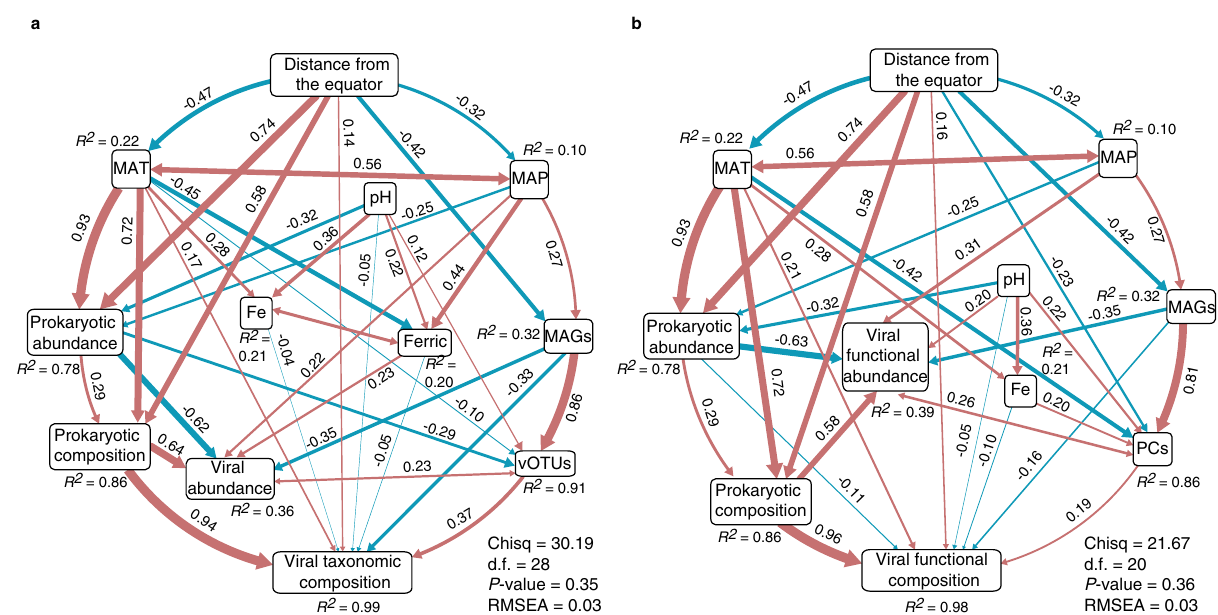
Fig. 3 Drivers of viral taxonomic and functional diversity and compositions. Path diagram for SEM showing only signi fi cant direct and indirect effects of biotic and abiotic variables on viral taxonomic a and functional b diversity and compositions. Composition is represented by the PC1 from the Bray-Curtis dissimilarity-based principal coordinate analyses. Numbers adjacent to the arrows are standardised path coef fi cients ( r ), analogous to relative regression weights and indicative of the effect size of the relationship. Blue and red arrows represent signi fi cant ( P < 0.05) positive and negative pathways, respectively. Double-headed arrows indicate covariance between variables, single-headed arrows indicate a one way directed relationship. R 2 represents the proportion of variance explained for every dependent variable in the model. The fi t of models was evaluated using one-tailed Chi-squared test and root mean square error of approximation (RMSEA). vOTUs, the number of viral operational taxonomic units; PCs, the number of viral protein clusters; Ferric, ferric iron; MAT, mean annual temperature; MAP, mean annual precipitation; and MAGs, the number of metagenome-assembled genomes. Source data are provided in the Source Data fi (Fig. 4d). Concomitantly, signi fi cant (Wilcoxon t -test, P < 0.001) higher virulent/temperate abundance ratios were observed in Thermoplasmatota -associated viruses than in Proteobacteria - associated viruses (Supplementary Fig. 4b). When averaged at the host phylum level, lineage-speci fi c host range (number of host populations for each viral population) and viral range (number of viral populations for each host population) were highest in Thermoplasmatota and Proteobacteria , respectively. Besides, the host range signi fi cantly increased with the prokaryotic richness (Pearson ’ s r = 0.45, P < 0.05), and the viral range signi fi cantly increased with the viral richness (Pearson ’ s r = 0.86, P < 0.001) across the host phyla (Fig. 5a). Further, increased prokaryotic decline in modularity (Fig. 5b, d) and signi fi cant increase in sediment samples (Fig. 5c, e).